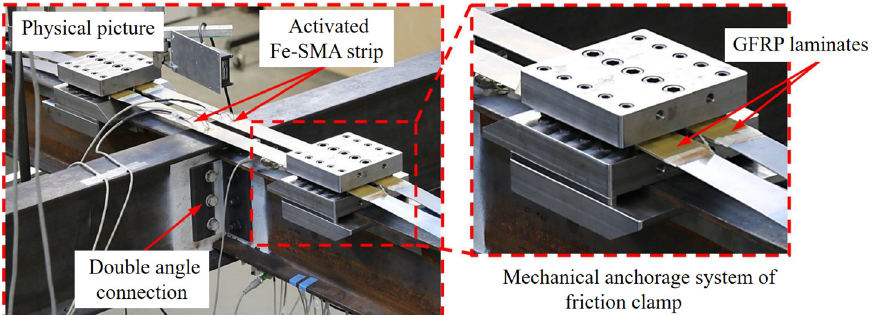
Figure 10. Friction clamp system and reinforcement details [103]. Table 6. Reinforcement applications of steel beams (plates) using Fe-SMA.